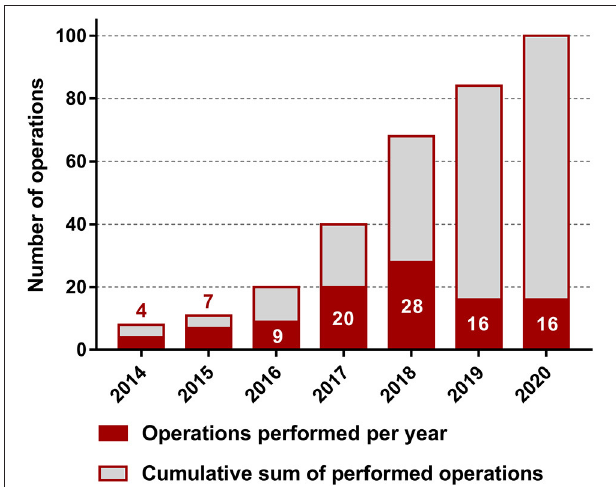
FIGURE 1 | Number of ELRAs completed per